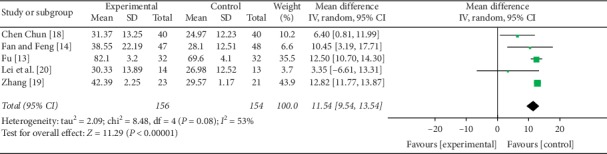
Forest plot of FMA.